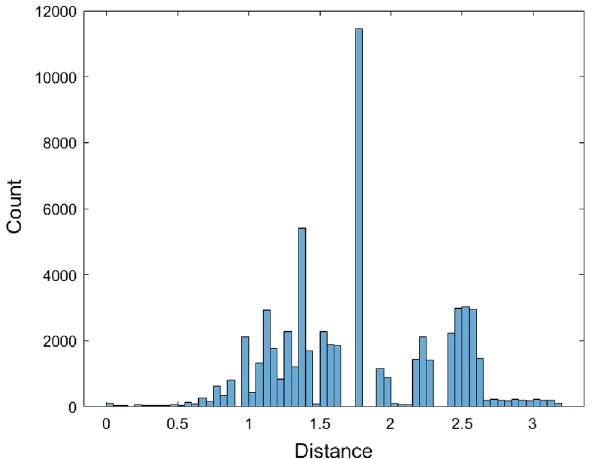
Figure 4. The histogram of 62,435 data generated from the fitted empirical distribution of the JC model distance data.